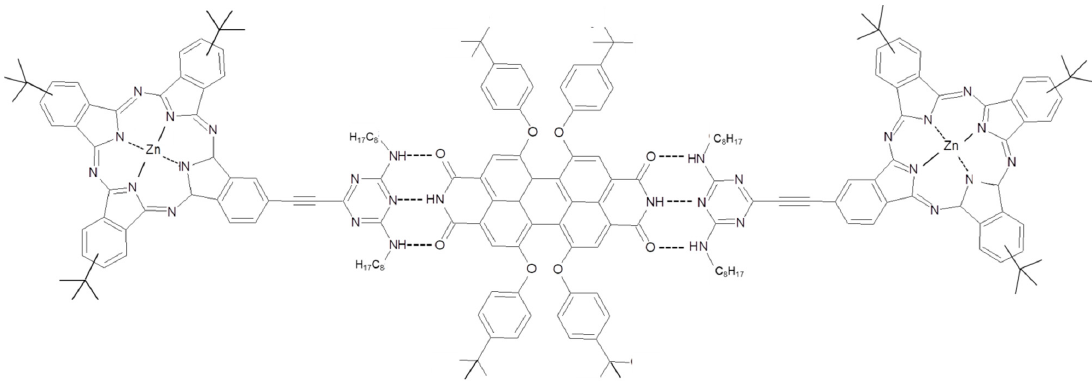
Figure 4. Chemical structure of Pc and PDI reported in the reference [69].